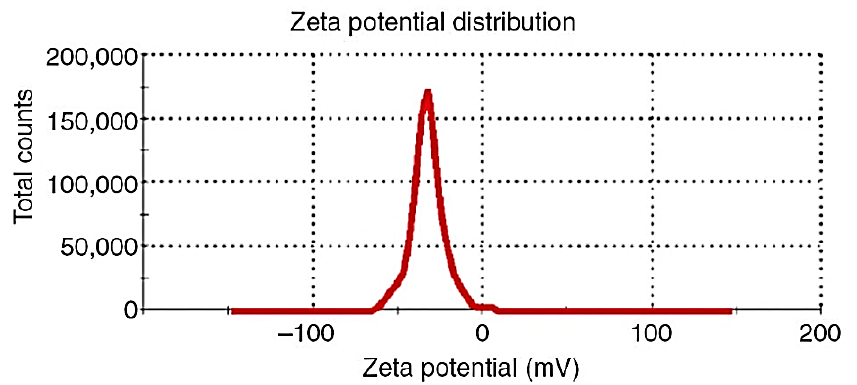
Figure 9. Zeta potential of GFT-CNP formulation